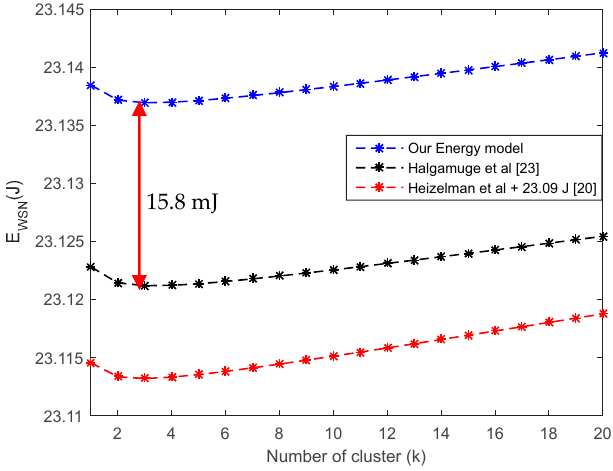
Figure 5. Average energy dissipation versus number of clusters (cid:1856) (cid:2887)(cid:2892)(cid:2879)(cid:2886)(cid:2903) = 110 m .